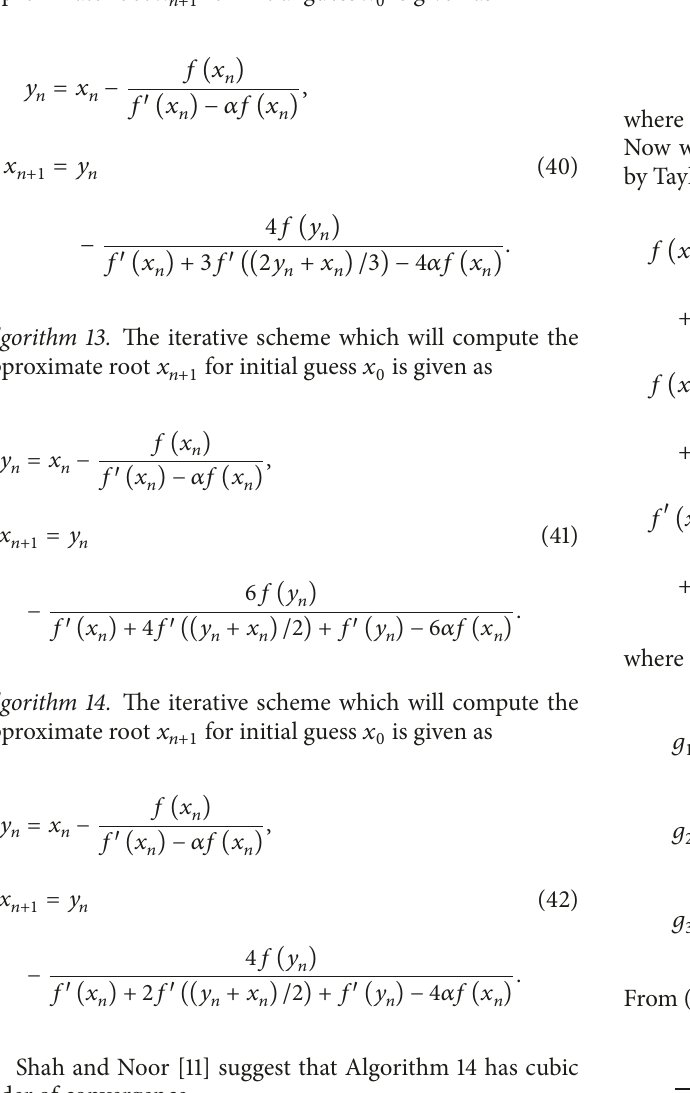
Algorithm 12. The iterative scheme which will compute the approximate root 𝑥 𝑛+1 for initial guess 𝑥 0 is given as